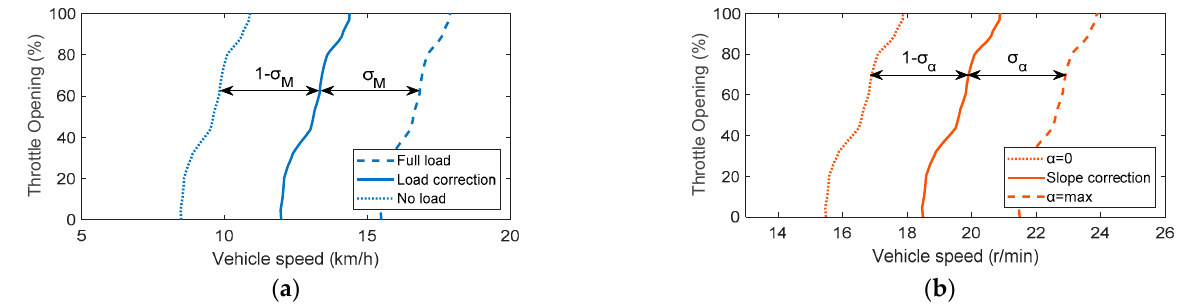
Figure 6. Modification of shift strategy based on ( a ) vehicle load and ( b ) road slope.